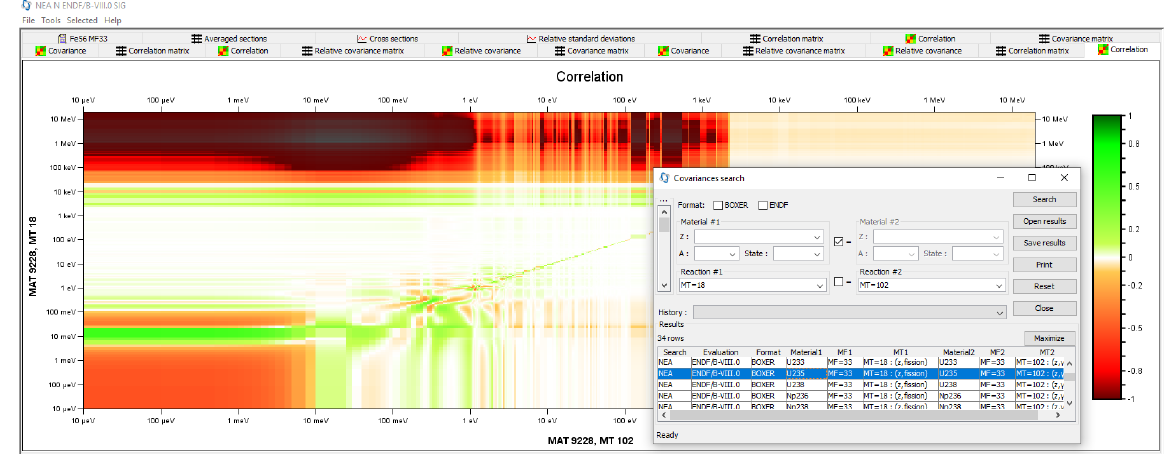
Figure 3. Cross-correlation covariance matrices from ENDF / B-VIII.0 between the fission and capture cross sections, shown using JANIS and reading from the NEA JANIS database.